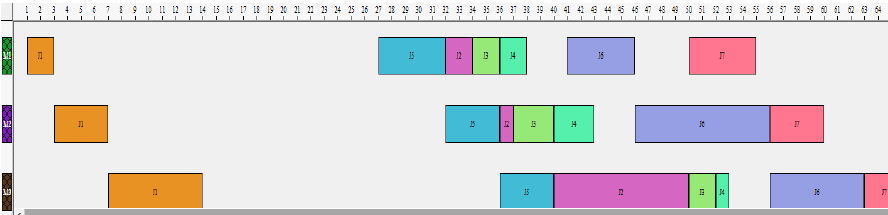
Figure 4. Gantt chart of the best solution with six jobs by ACO.